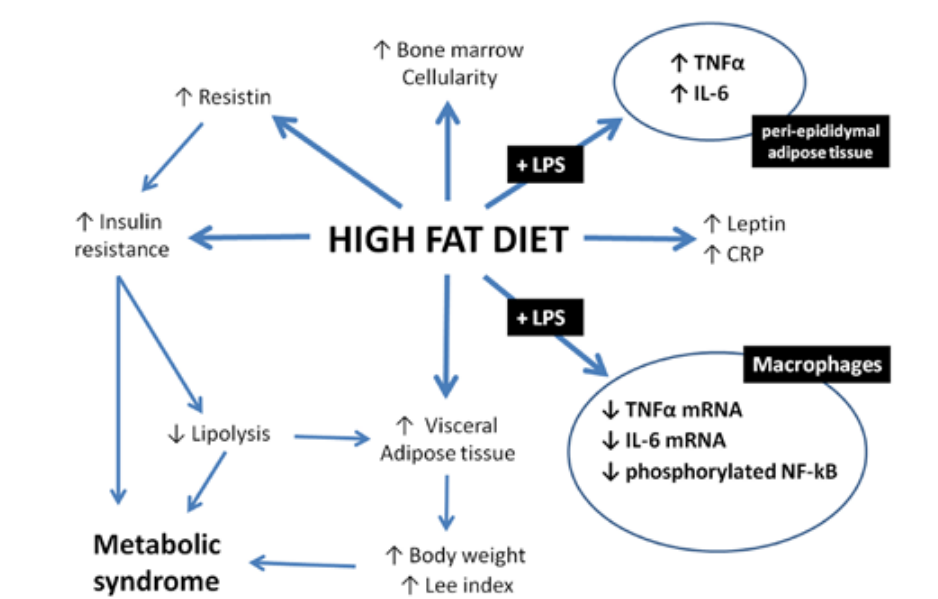
FIGURE 6 – Metabolic disorders associated with high fat diet. The diagram shows the processes affected by high fat diet. Abbreviations : NF-KB, nuclear factor kappa B; TNF, tumor necrosis factor; IL-6, Interleukin-6; LPS,